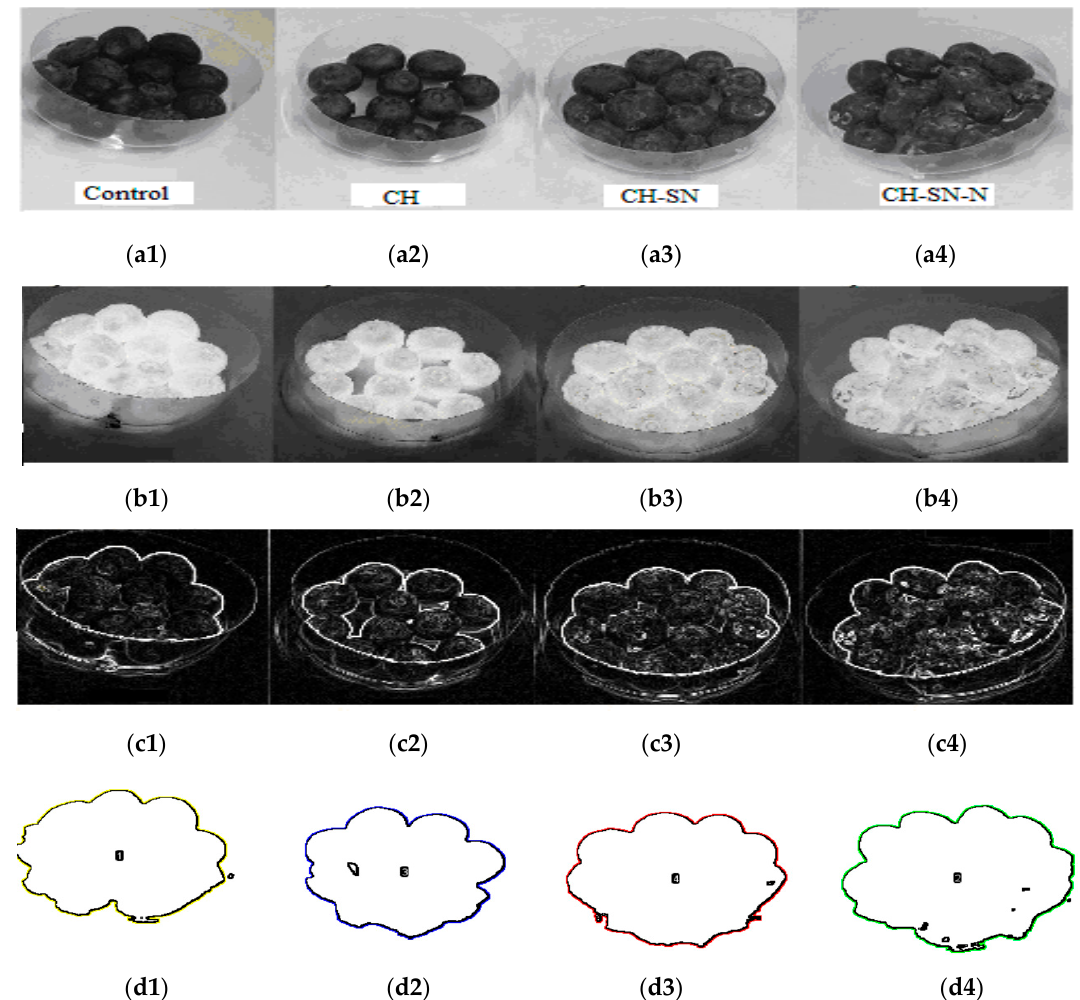
Figure 12. Blueberries image segmentation; H2O-Control image ( a1 ), Chitosan image (CH) ( a2 ), Chitosan/Silica Nanoparticle image (CH-SN) ( a3 ), and Chitosan/Silica Nanoparticle/Nisin image (CH-SN-N) ( a4 ). Inverse images ( b1 ), ( b2 ), ( b3 ) and ( b4 ), Sobel edge extraction ( c1 ), ( c2 ), ( c3 ), ( c4 ), and color segmented regions ( d1 ), ( d2 ), ( d3 ), ( d4 ), respectively. Table 5. Morphological characteristics of blueberry’s regions.